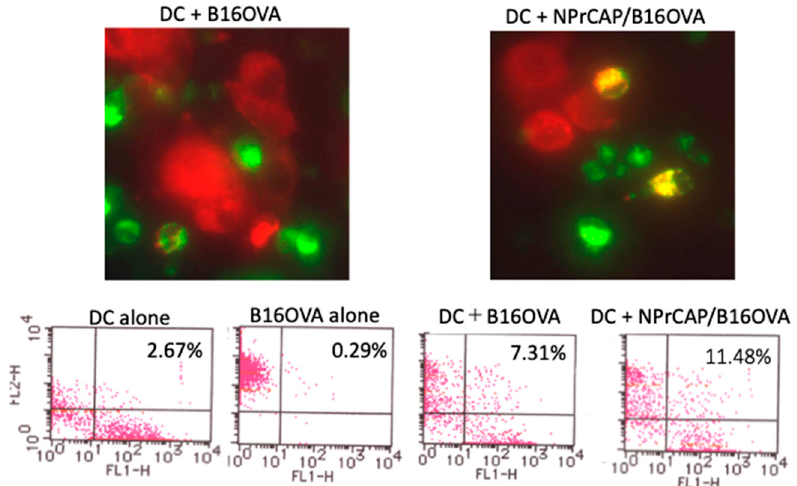
Figure 8. BMDCs take up N -Pr-4- S -CAP-treated B16-OVA melanoma cells. PKH-red-labeled B16- OVA cells treated with/without N -Pr-4- S -CAP were cocultured with PKH-green-labeled BMDCs for 6 h. Phagocytosed B16-OVA cells were then analyzed using fluorescent microscopy (original magnification × 100), upper column) and a flow cytometry (lower column).